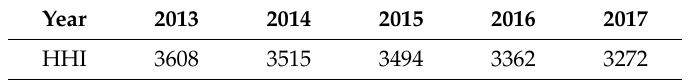
Table 3. Values of the Herfindahl–Hirschman Index (HHI) index in period 2013–2016.